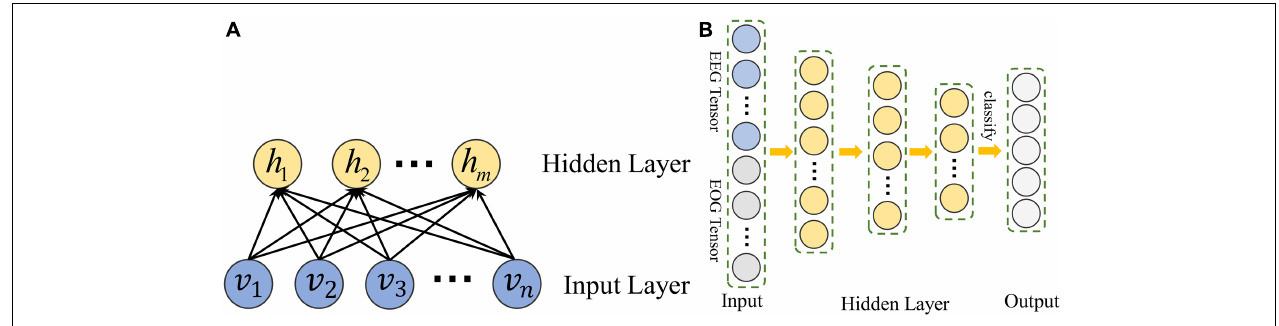
FIGURE 2 | The structure of DBN constructed in MSDFN. (A) The structure of RBM; (B) The structure of DBN.